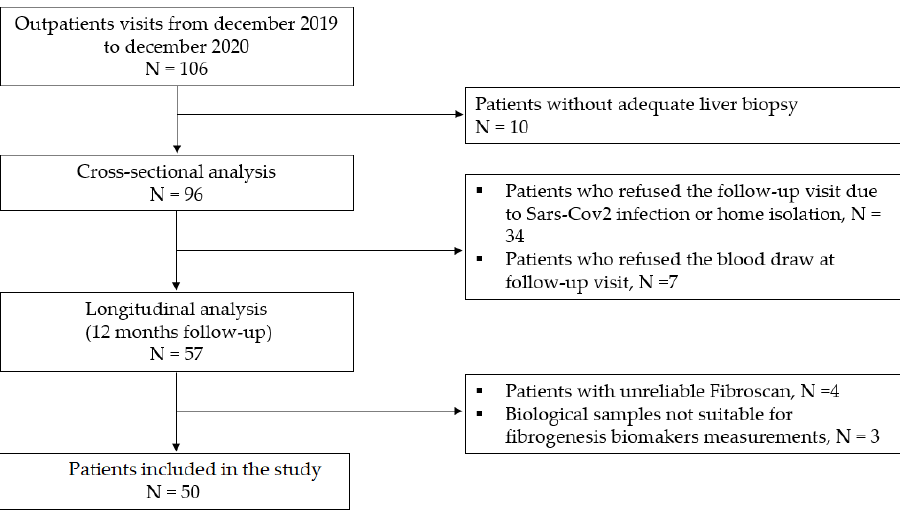
Figure 1. Flow-chart of the study.